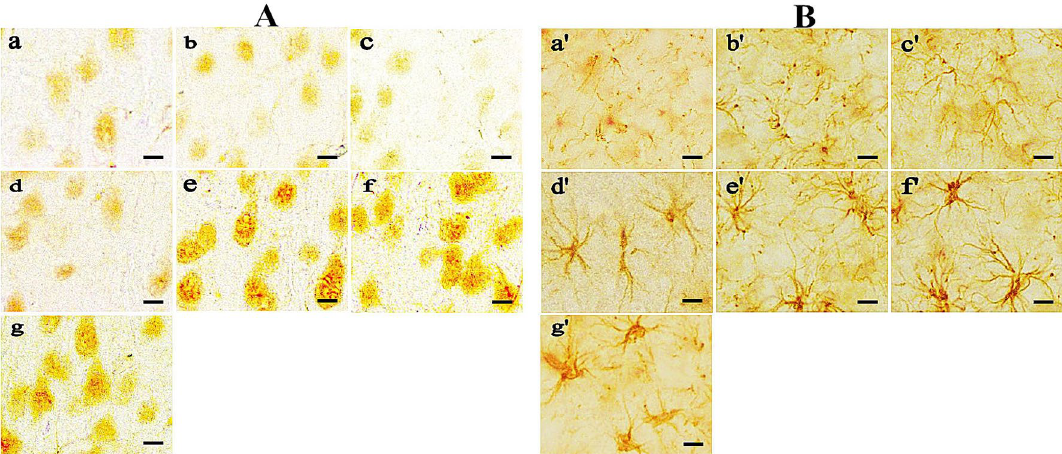
Figure 3. Immunohistochemical staining (3,3-diaminobenzidine (DAB) chromogen method) of MCT2 ( A ) and MCT4 ( B ) in the cerebral motor cortex of rats in each group. a,a’ control group, b,b’ NE group, c,c’ REIA